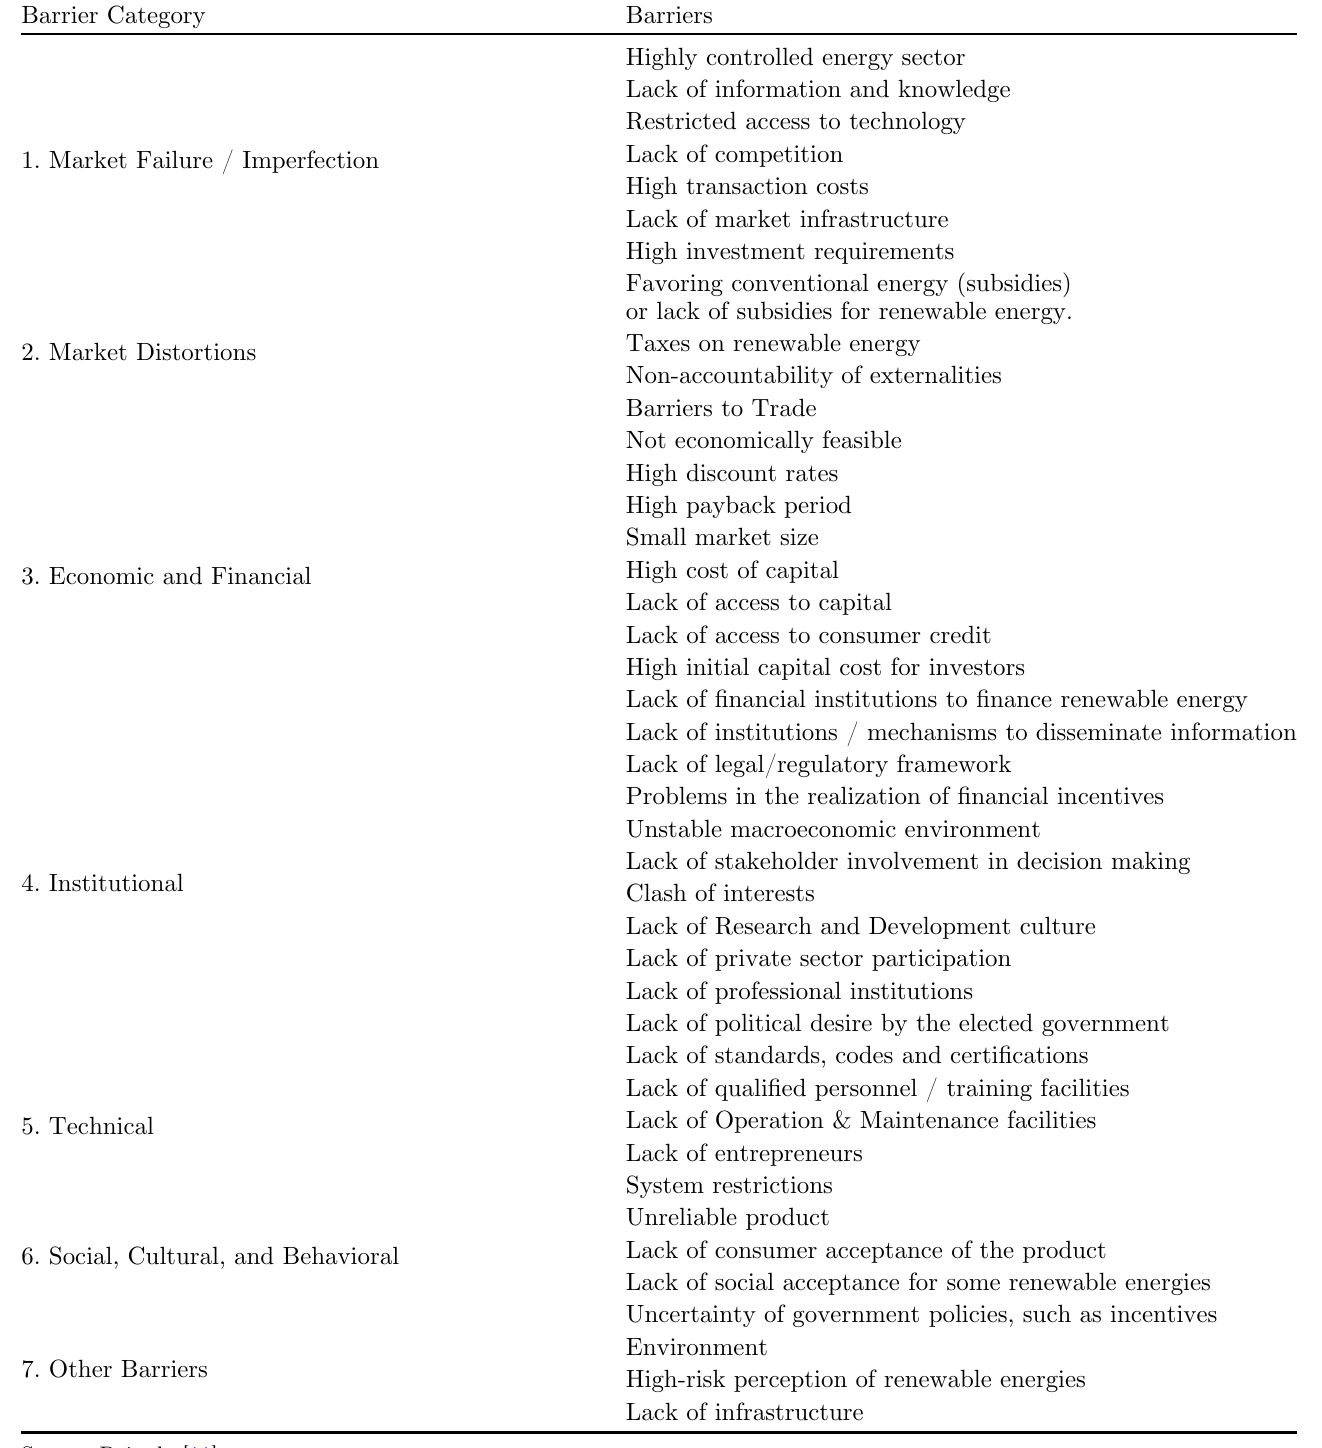
Table 3. Barriers to renewable energy